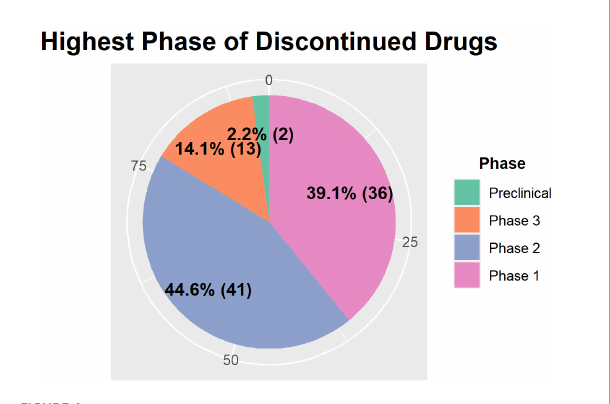
FIGURE4 The summary of the highest phase of clinical development before discontinuation. The number and proportion of each phase is displayed in bold, and the numbers (0, 25, 50, and 75) on the outer ring represent the cumulative percentage the area of the pies take up. Preclinical and phase 3 assets take up less than 25% of the assets, whereas phase 2 assets take up 44.7% ( n = 42) and phase 1 assets take up 39.4% ( n = 36) of the total